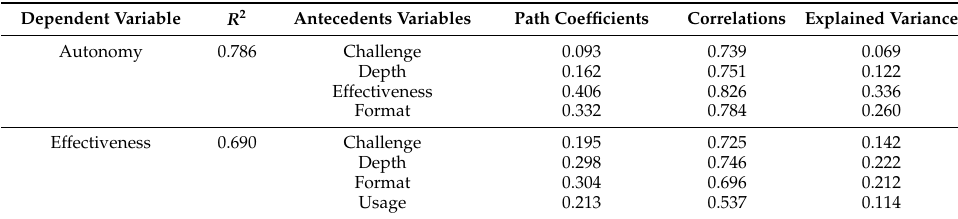
Table 6. Decomposition of the explained